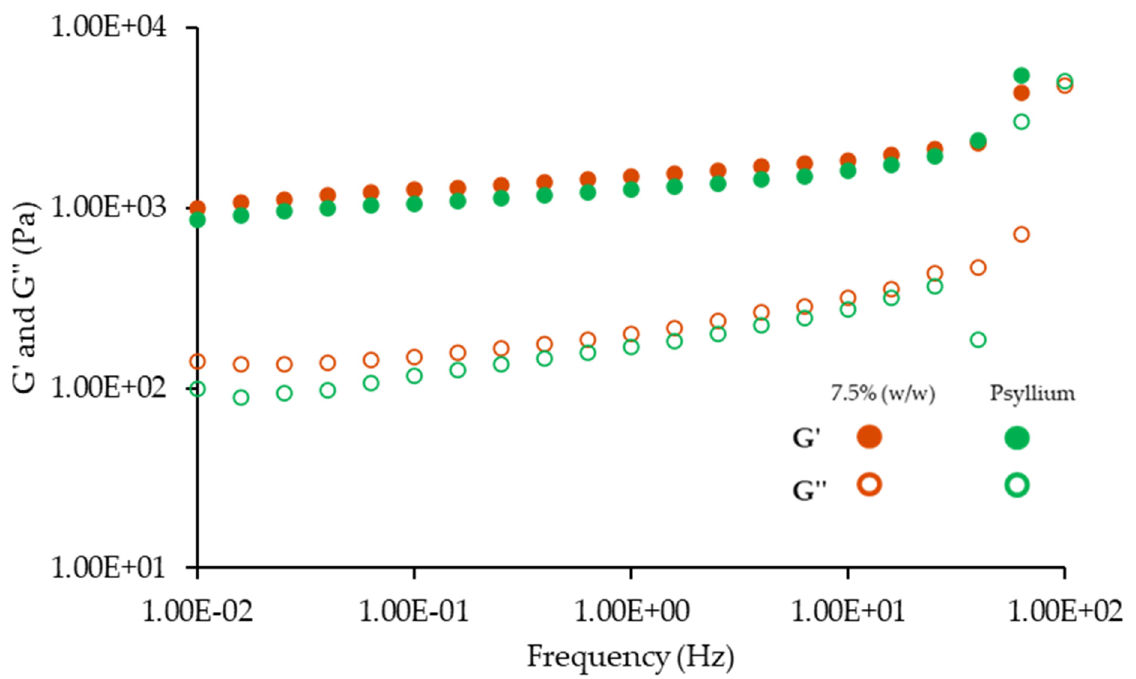
Figure 6. Mechanical spectra of emulsions with 7.5% ( w / w ) of miso paste, one of them with 0.1% ( w / w ) of psyllium husk. G ′ corresponds to the elastic modulus and G ″ corresponds to the viscous of psyllium husk. G (cid:48) corresponds to the elastic modulus and G” corresponds to the viscous modulus.